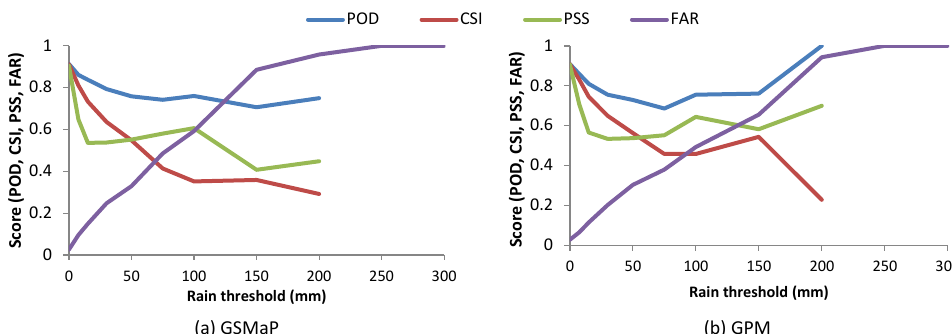
Figure 10. Composite mean TC rain forecasts skill scores using ( a ) GSMaP and ( b )